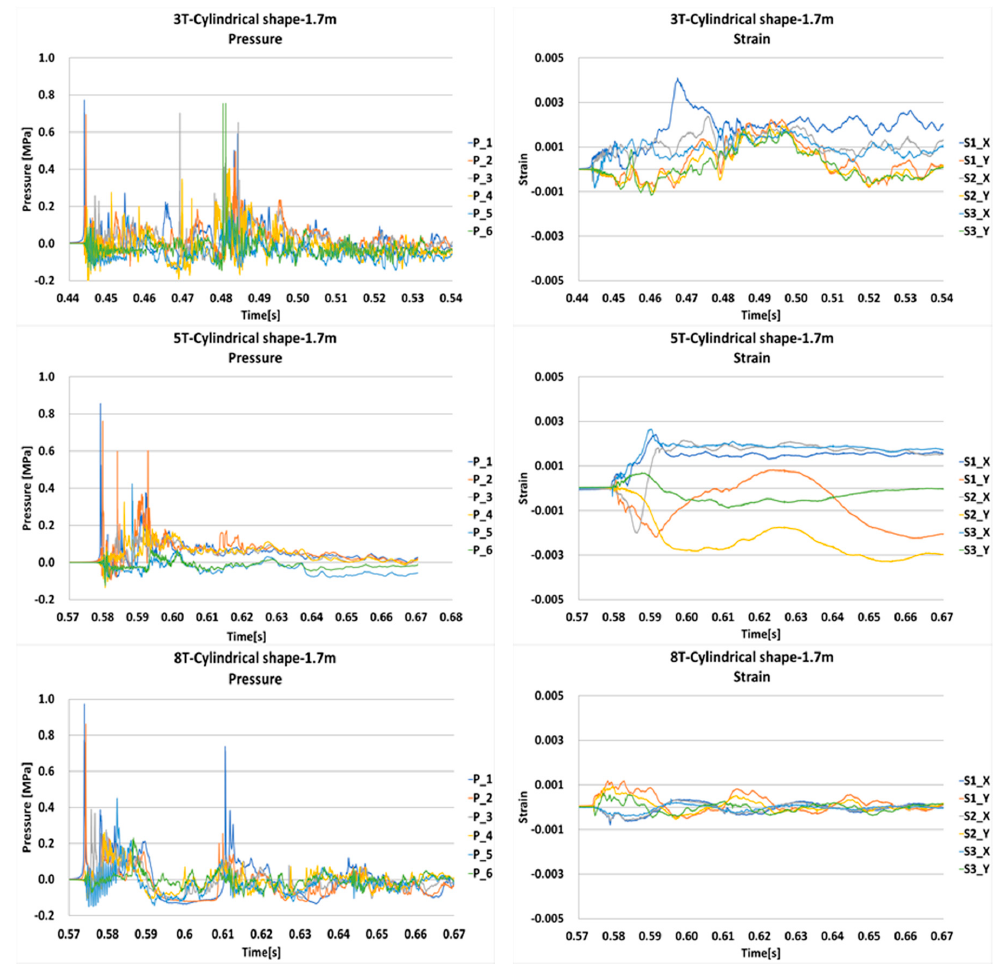
Figure 12. History of pressure and strain in the cylindrical model (Drop height: 1.7 m).